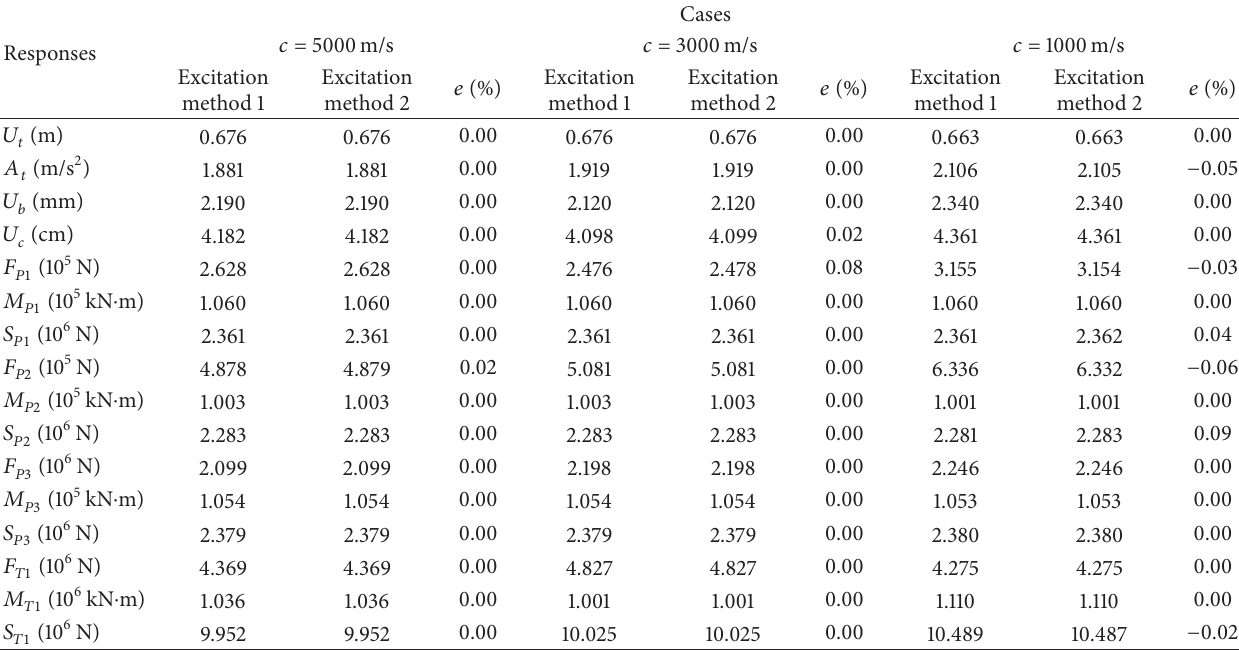
Table 8: Comparisons of the structural peak seismic responses under different excitation methods under the excitation of 𝑐 1 .